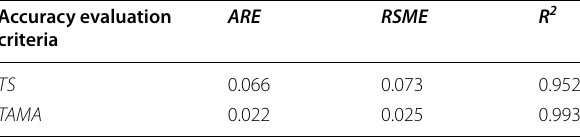
Table 11 Evaluation of the accuracy of the surrogate models Accuracy evaluation